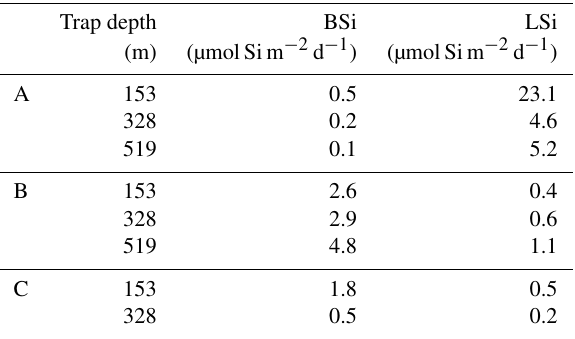
Table 3. Particulate biogenic and lithogenic (BSi and LSi) silica in drifting sediment traps at each long-duration station during OUT- PACE cruise, at 153, 328 and 519m